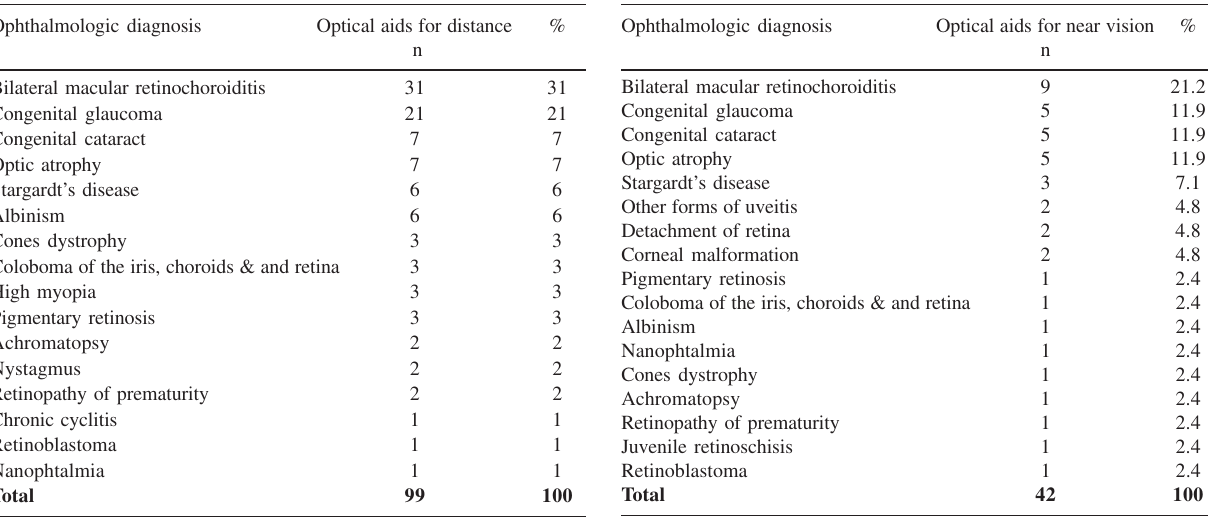
Table 7 - Distribution of prescribed optical aids for near distance by ophthalmologic diagnosis Ophthalmologic